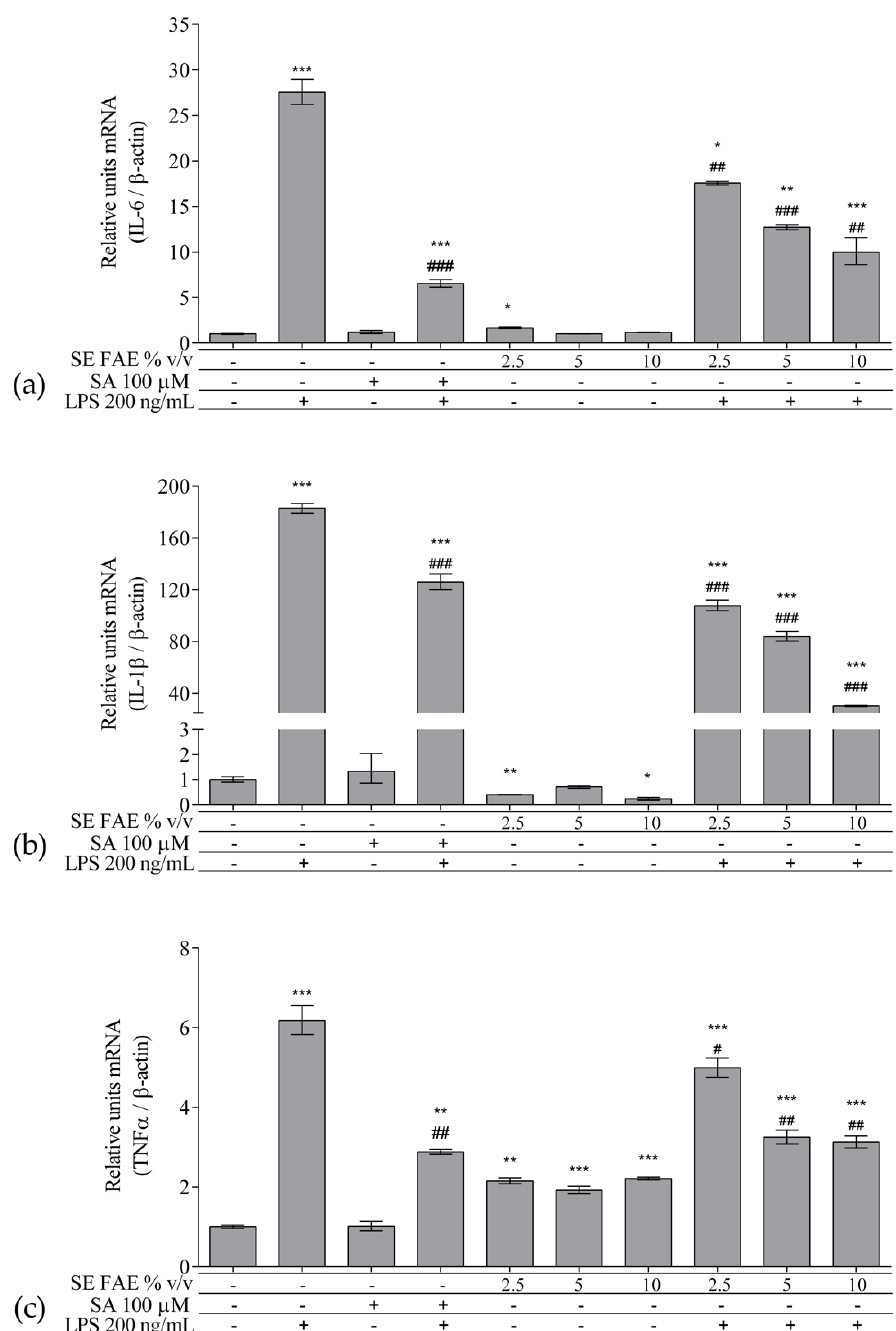
Figure 1. Changes in mRNA levels of IL-1 β ( a ), IL-6 ( b ), and TNF α ( c ) in J774A.1 mouse macrophages pre-treated with increasing concentrations (2.5%, 5%, 10% v / v ) of SE FAE or with SA for 24 h and subsequently stimulated or not with LPS. Results were obtained using qPCR technique. Data are presented as mean ± SEM. Legend: SE FAE– Sambucus ebulus L. fruit aqueous extract; SA–100 µ M salicylic acid; LPS–200 ng/mL lipopolysaccharides. * p < 0.05, ** p < 0.01, *** p < 0.001 vs. untreated cells; # p < 0.05, ## p < 0.01, ### p < 0.001 vs. LPS.